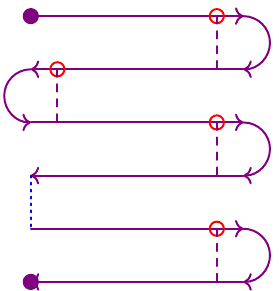
Figure 3: The allowed flips (denoted by vertical dashed lines) that give rise to 2 2 q − 1 choices of placing the turning-point operators. There are q future turning-point op- erators and q − 1 past turning-point operators. Each of them can be chosen to come before or after the turning-point leading to an irreducible degeneracy of 2 2 q − 1 con- tour correlators which evaluate to same single time correlator. In the ‘canonical’ ar- rangement we fix these 2 2 q − 1 choices by demanding that the turning-point operators be placed always before the